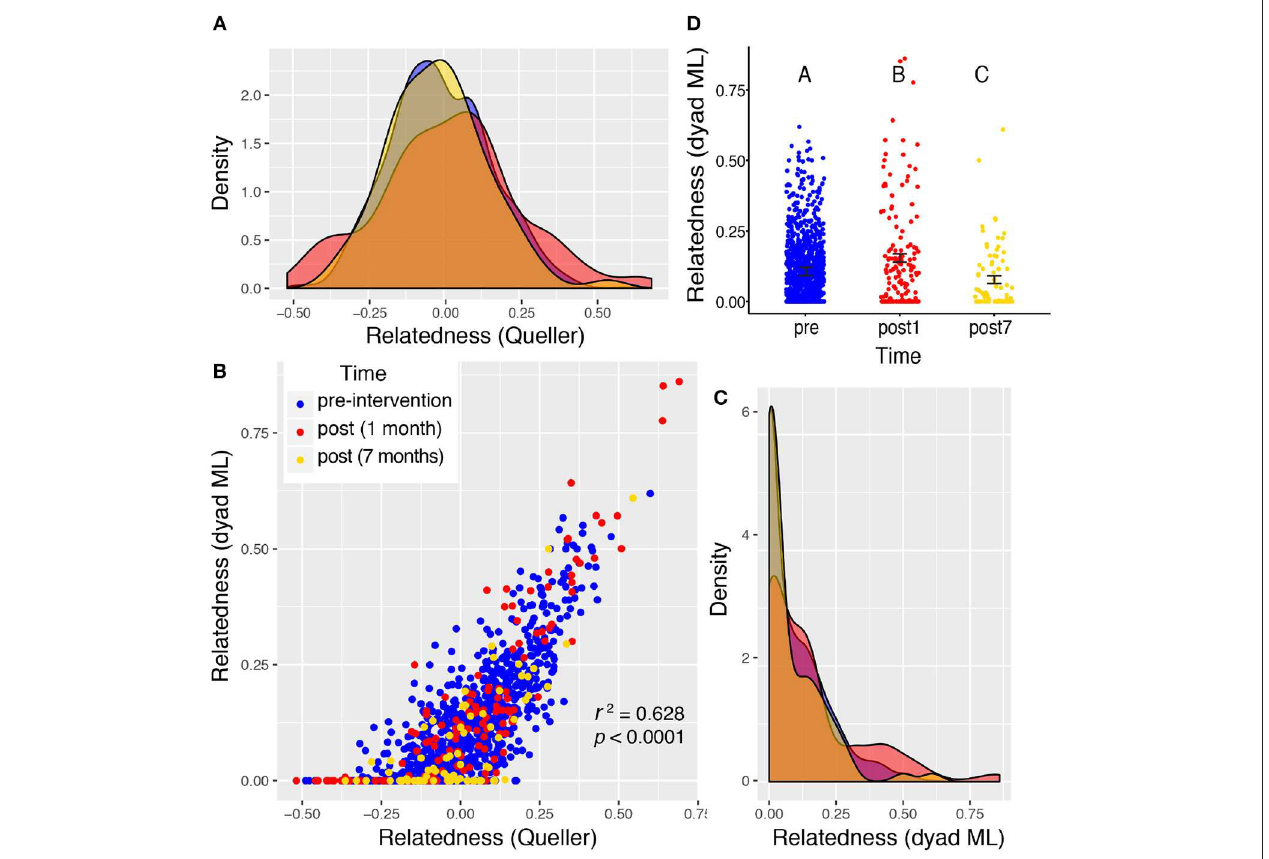
FIGURE 5 | Valley 2: two very different measures of relatedness suggest that there is a significant change in the distribution of relatedness between individual rats sampled pre- and post-eradication in Valley 2, represented by density distributions below (A,C) . The Queller-Goodnight relatedness coefficient can take negative values (A) , while the Milligan dyad maximum likelihood (dyad ML) metric is bounded by zero and one (C) . The two metrics are tightly correlated in this data set (B) . A Kruskal–Wallis test was used to determine if the distribution of relatedness values differed among the three time points sampled around the 2015 eradication campaign (D) . The upper-case letters above the points in panel (D) indicate that there is a significant difference between all three distributions of relatedness among the one pre- and two post-eradication periods. Black bars represent the mean ±